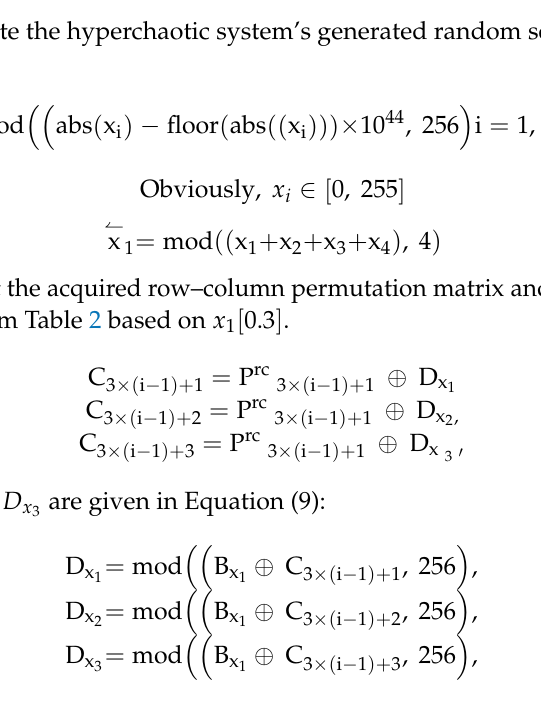
Table 2. Comparative analysis between the proposed and existing